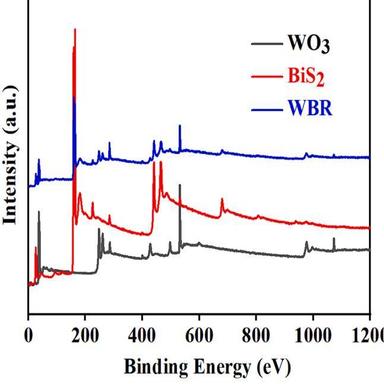
X-ray Photoelectron Spectroscopy (XPS) data for rGO, WO3, BiS2, and WO3/BiS2/rGO nanocomposite.